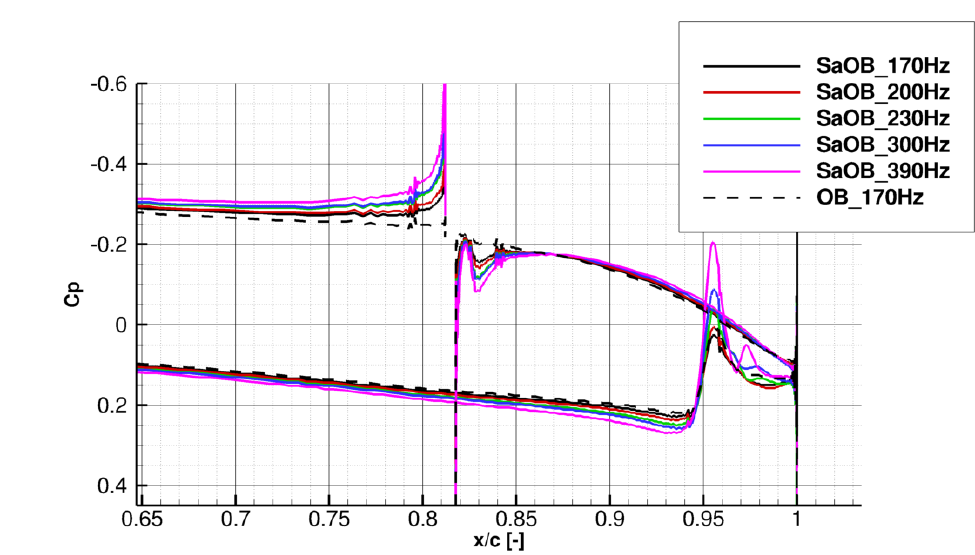
Figure 16. Cp distribution of the SaOB cases.